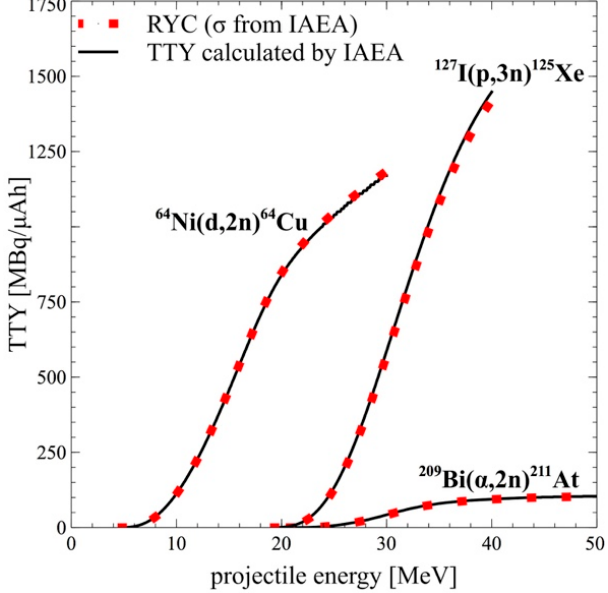
Figure 1. Comparison of TTY for selected nuclear reactions on metallic targets calculated with RYC and adapted from [28,35] based on the same cross-section values from IAEA.